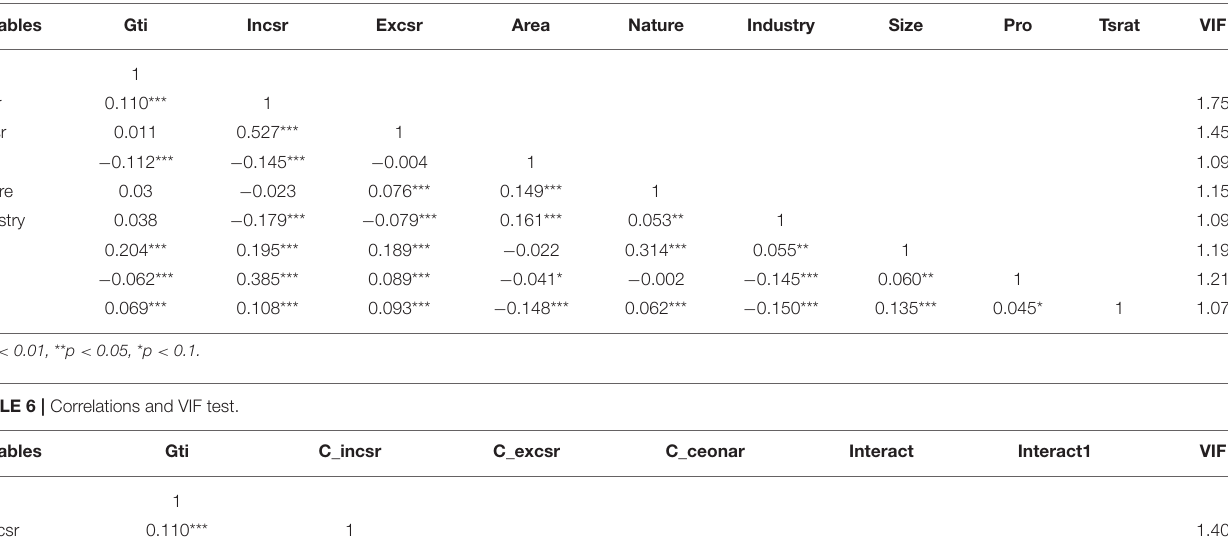
TABLE 5 | Correlations and VIF test.